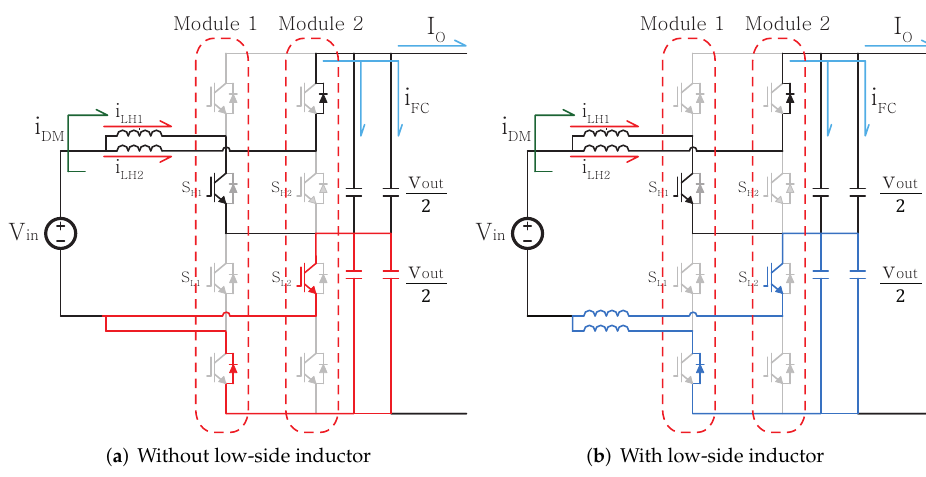
Figure 2. Circuit diagram of two-phase parallel